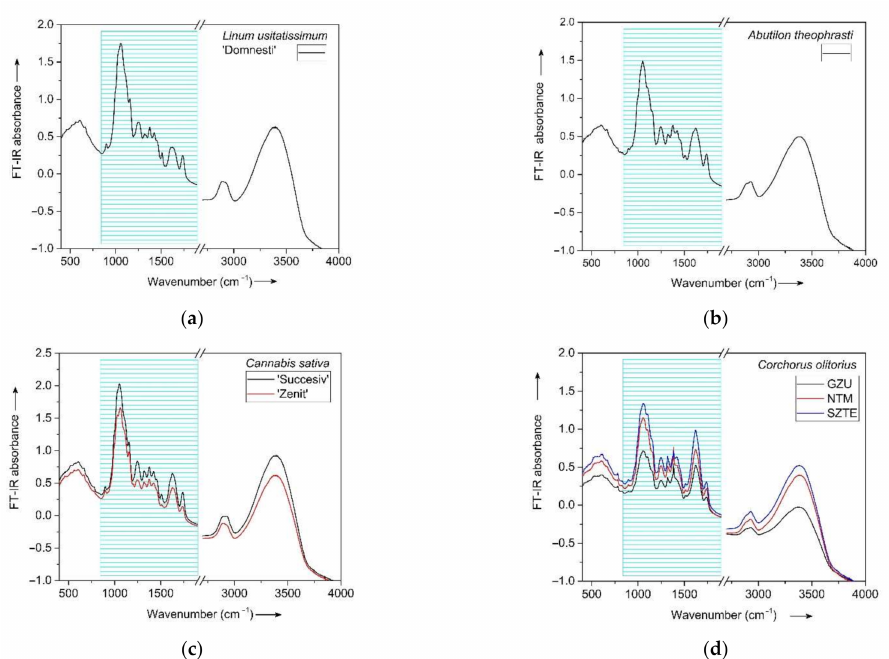
Figure 4. FT-IR spectra for stems of flax ( a ), velvet leaf ( b ), hemp ( c ) and jute ( d ), showing the regions selected for detailed